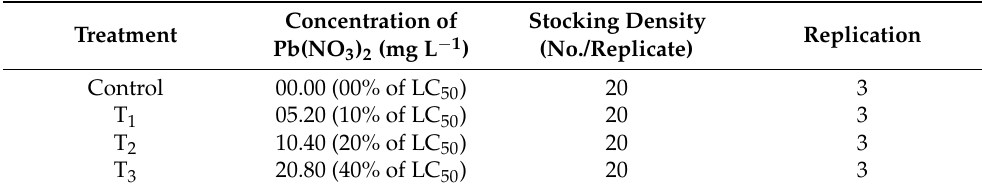
Table 1. Experimental design with different dosages of Pb(NO 3 ) 2 exposure.